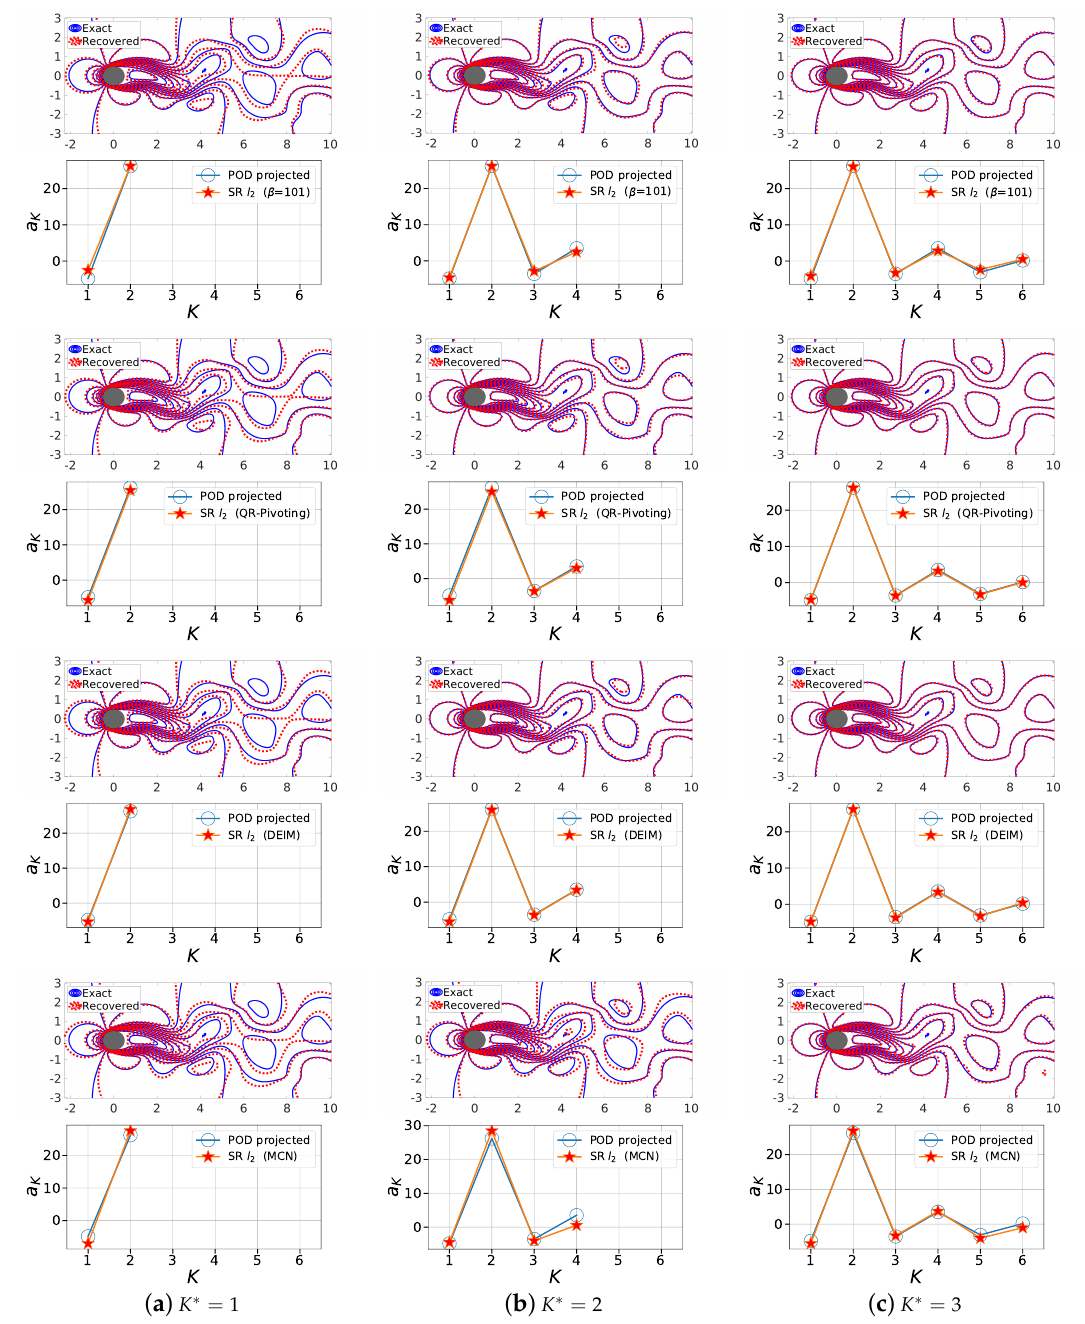
Figure 14. First row (Random β = 101), third row (QR-Pivot), fifth row (DEIM) and seventh (MCN) row: we show the line contour comparison of streamwise velocity between the actual CFD solution field (blue) and the POD-based SR reconstruction (red) for Re = 100 at P ∗ = 10 and ( a ) K ∗ = 1, ( b ) K ∗ = 2, ( c ) K ∗ = 3. Second row (Random β = 101), fourth row (QR with column pivoting), sixth row (DEIM) and eighth row (MCN) show the corresponding projected (full reconstruction) and sparse recovered coefficients a from the SR